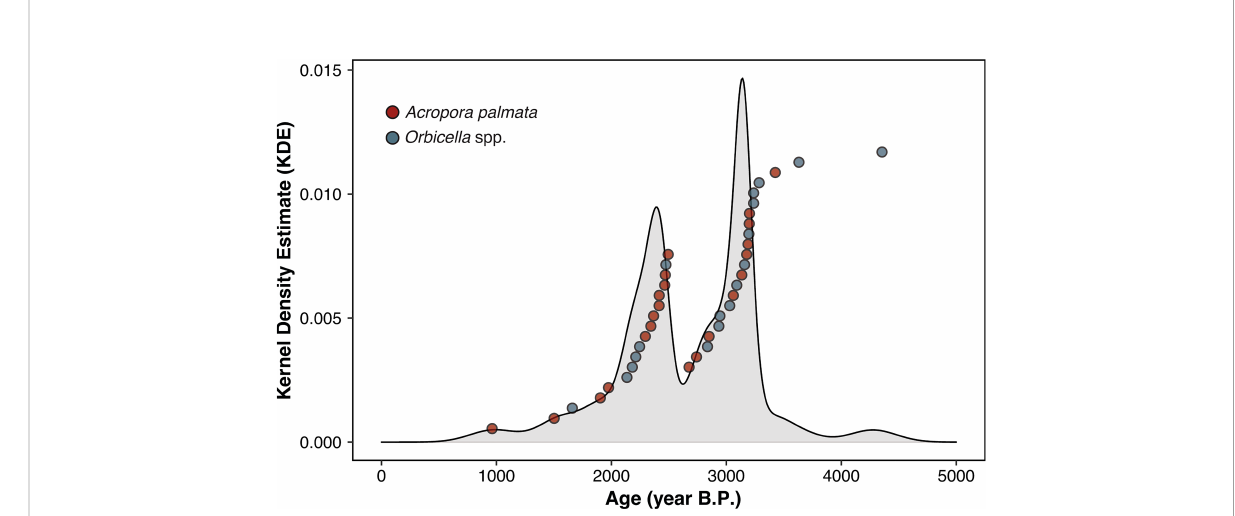
FIGURE 2 Kernel Density Estimate distribution curve produced from the U-Th age data [in years before present (BP)] obtained from subfossil Acropora palmata and Orbicella spp. coral skeletons (see Supplementary material for more details). Individual U-Th ages are shown as